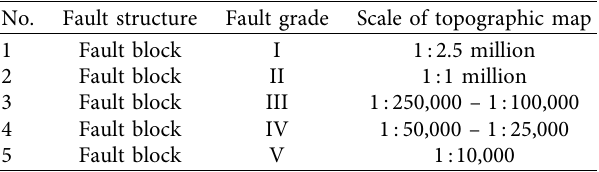
Figure 1: Geodynamic environment of the Table 1: Proportional range of fault blocks in geodynamic zoning.